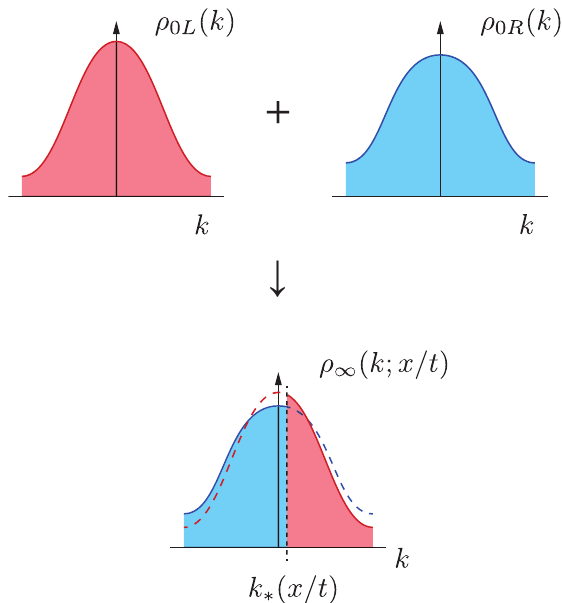
Figure 3: The asymptotic momentum distribution at large distances and times is a stepwise combination of the initial ones on the left and right